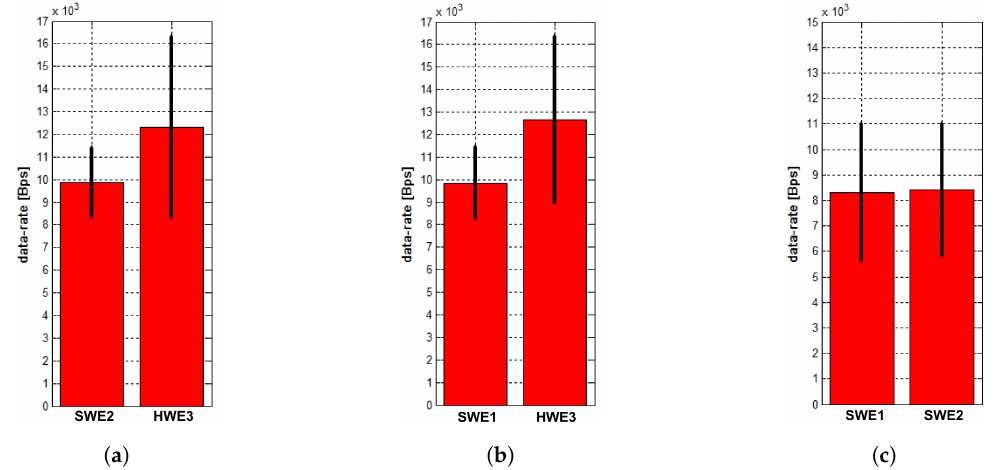
Figure 10. Mean values and standard deviation of data rates of transmissions from neighbors measured at entities ( a ) SWE 1 ; ( b ) SWE 2 ; and ( c ) HWE 3 in the MR scenario using the high-fidelity MR